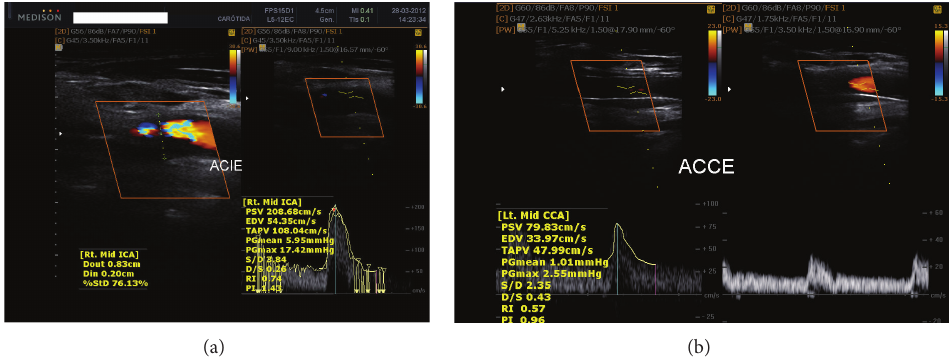
Figure 3: Ultrasonography of the carotid arteries showing the presence of plaques in the left internal carotid artery (a) and left internal carotid artery after stent implantation